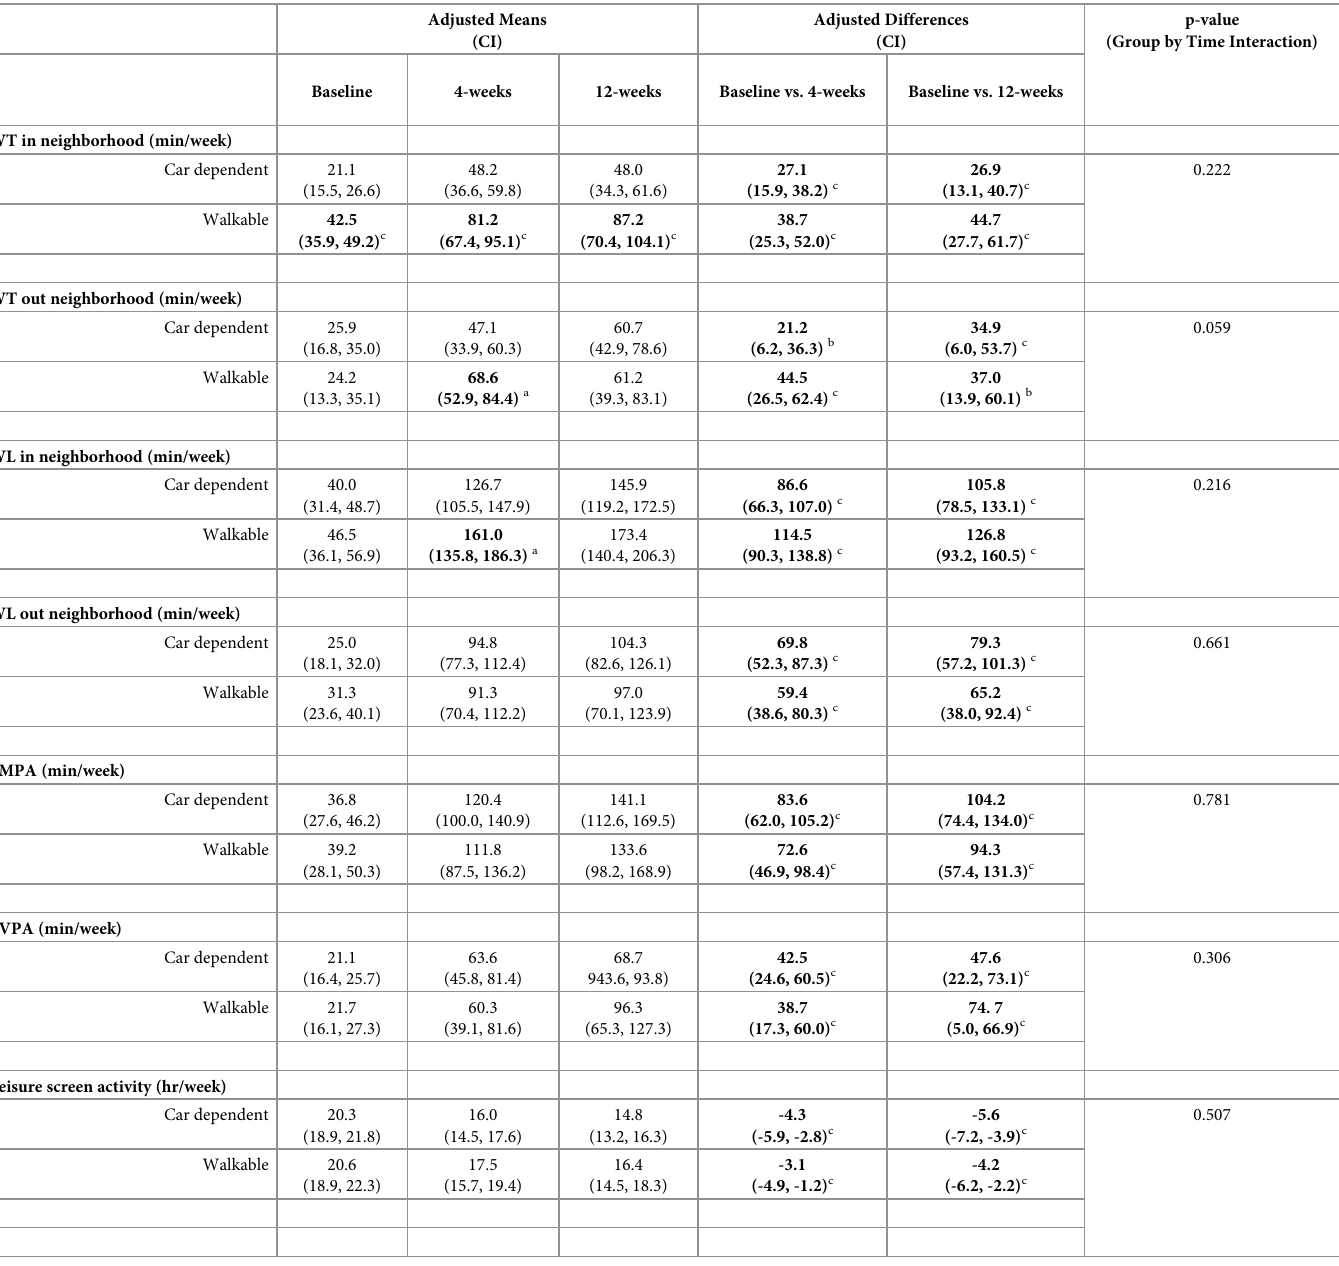
Table 3. Estimated adjusted means and difference between neighborhood type and time during UWALK.